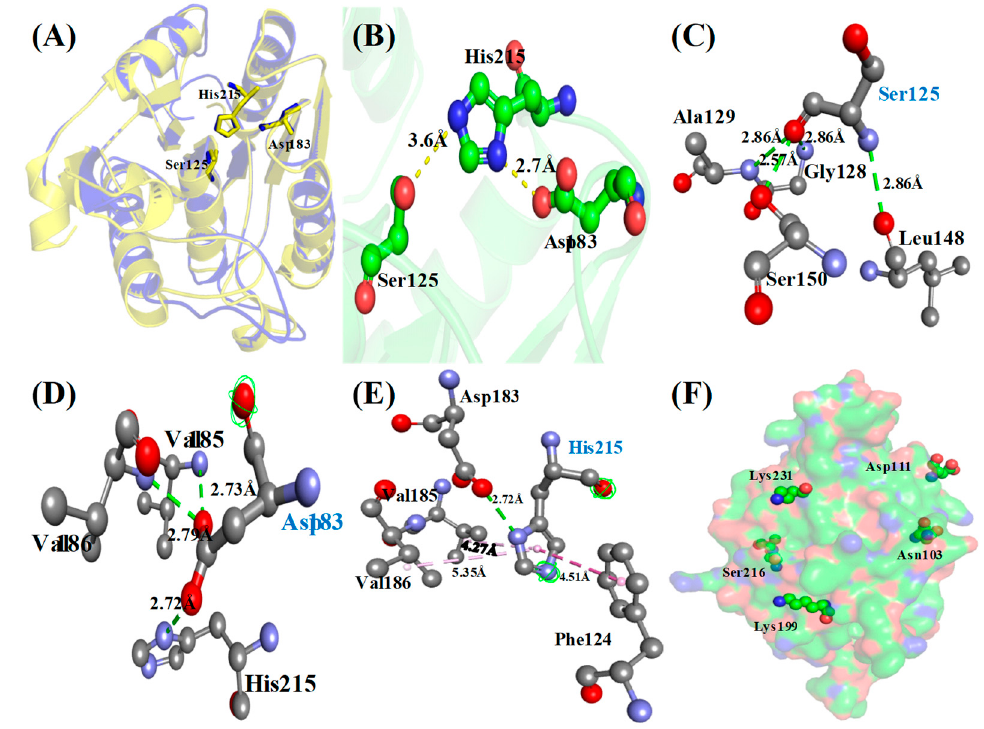
Figure 5. Homology model of TmPLB1 and identification of catalytic triads. ( A ) Homology model of TmPLB1 aligned with a template (PDB: 1FJ2). The proposed catalytic triad residues such as Ser125, Asp183, and His215 were shown in stick representation. ( B ) The arrangement of catalytic triads. The interactions of ( C ) Ser125, ( D ) Asp183, and ( E ) His215 with other amino acids near the active sites. Putative hydrogen bonds were indicated with green lines, while hydrophobic interactions were indicated with purple lines with distances labeled. ( F ) Putative phosphorylated sites on the surface of